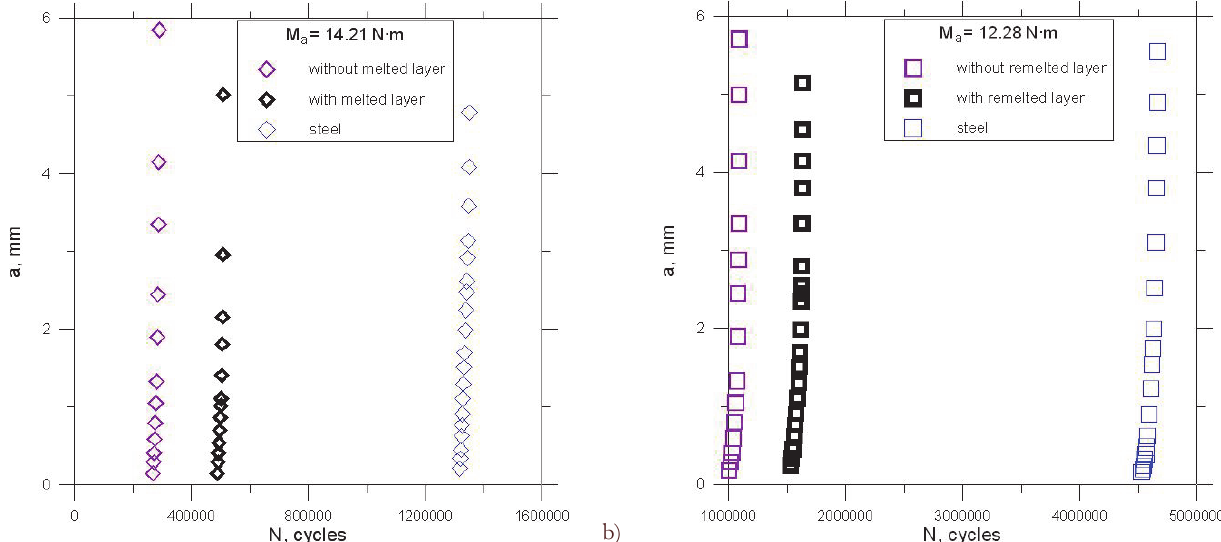
Figure 6: Cracks length vs. number of cycles for amplitude of bending moment: a) 14.21 N  m, b) 12.28 N  m. Fatigue crack growth initiated in steel and propagated toward zirconium in both cases. Two different interaction mechanisms between a crack and an interface were observed. In case of bimetal without melted layer crack penetrated interface (Fig. 7a) and propagated in zirconium.